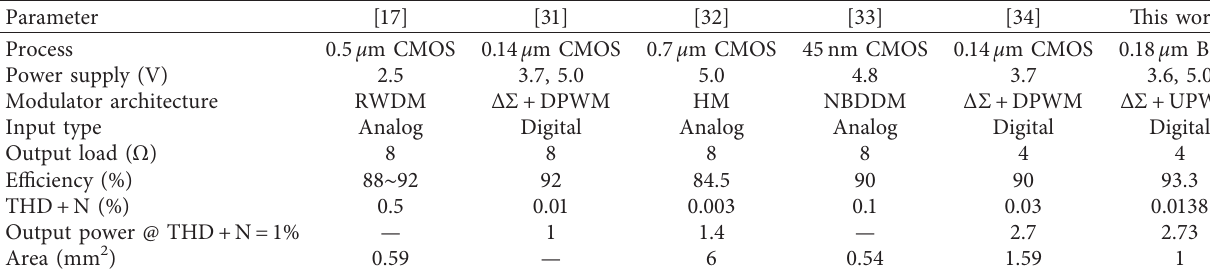
Figure 18: THD versus output power at a 4 Ω load with transient Table 1: The comparison with literature.